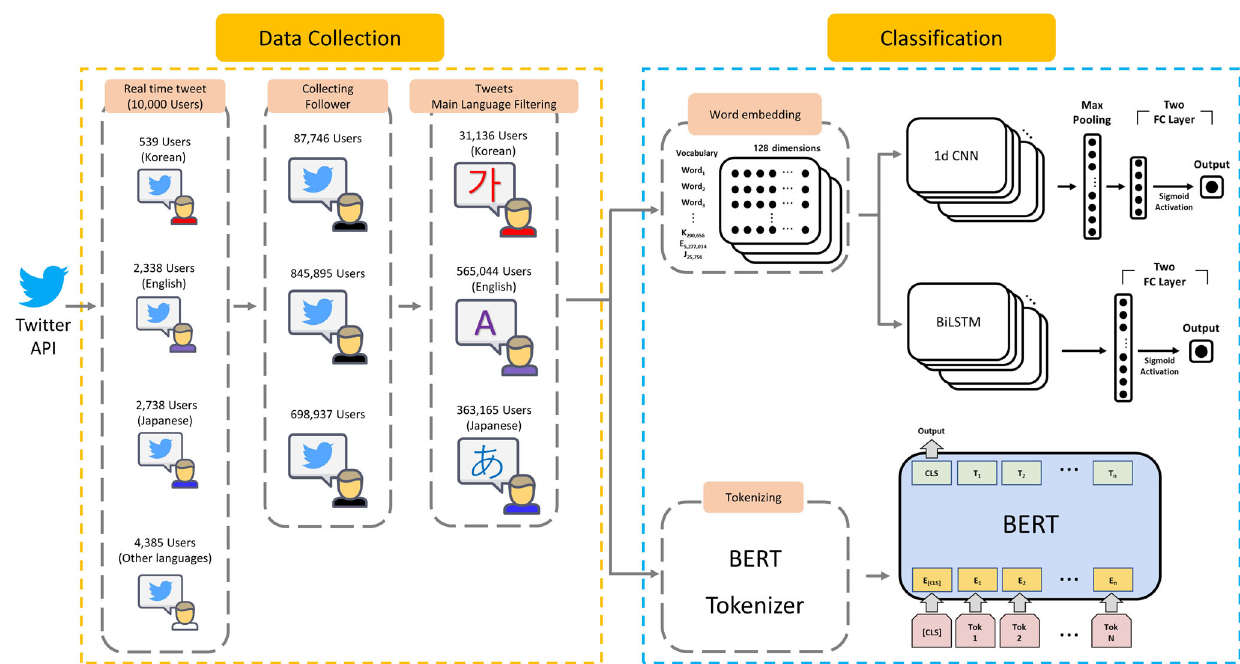
Fig. 1 An work fl ow of data collection and architecture of the proposed CNN, BiLSTM, and BERT-based classi fi cation model.